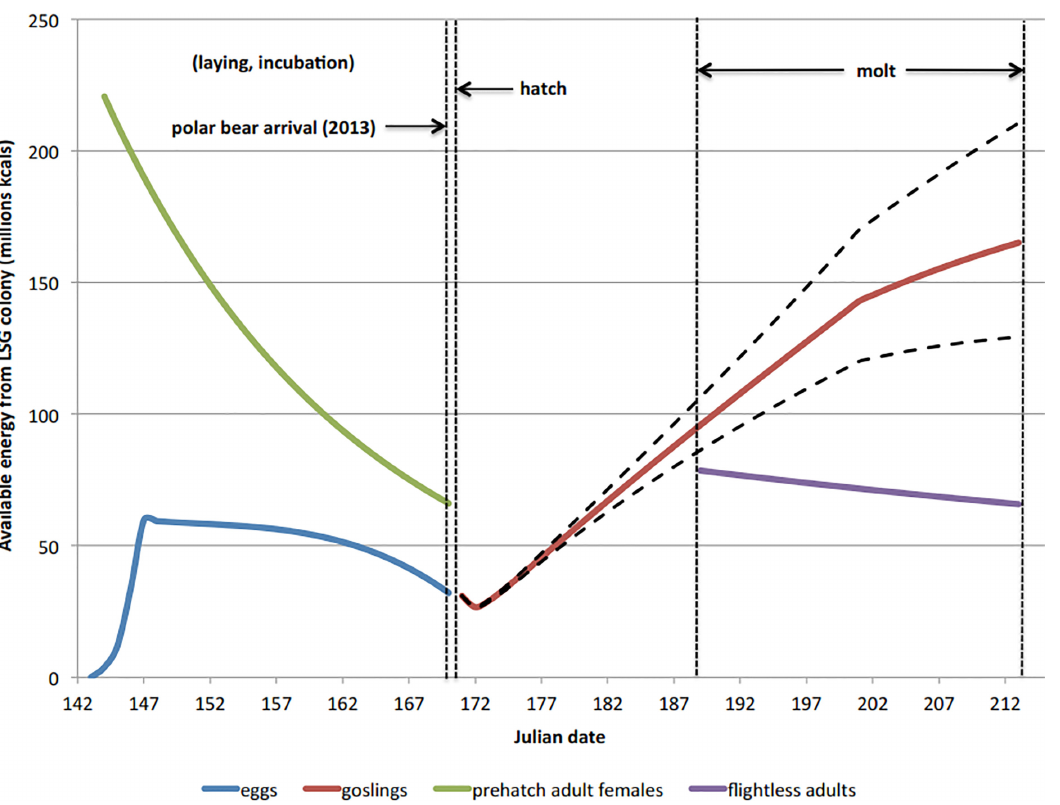
Fig 2. The total available energy from snow geese and their eggs during the laying, incubation, post-hatch and molting stages of their life cycle that occurs in the Cape Churchill Peninsula. The mean hatch and polar bear arrival dates provided (left-most vertical dashed lines) are for 2013, however, if the ice-free season expands to 180 days, polar bears would arrive before nesting geese and thus have access to all the available energy